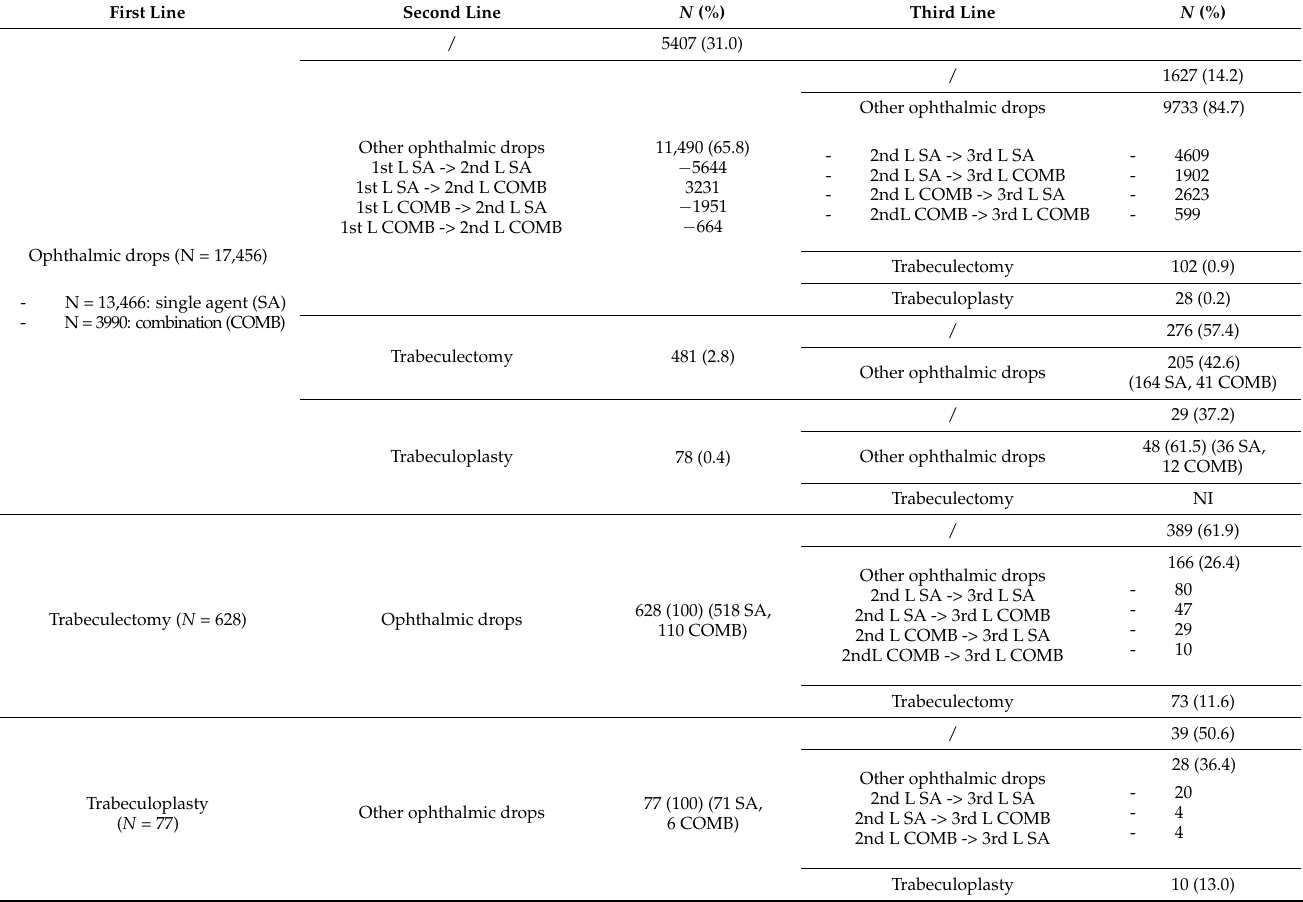
Table 2. Sequencies of therapeutic lines in patients with glaucoma.